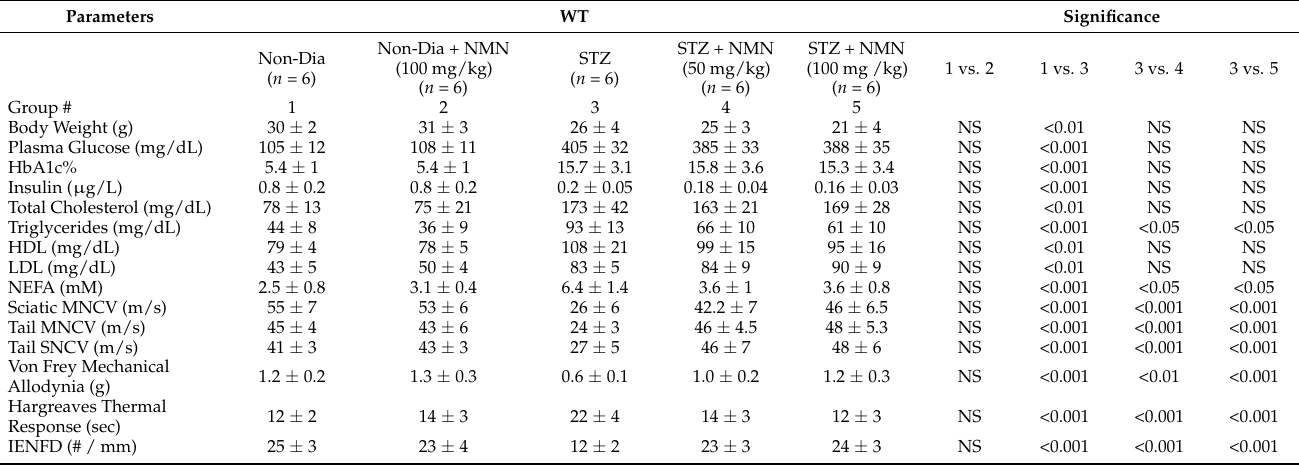
Table 2. Metabolic End Points After 2 Months of Treatment in Non-Diabetic (Non-Dia), Non- Dia + NMN (100 mg/kg intraperitoneal injection on alternate days), Diabetic (STZ), STZ + NMN (50 mg/kg intraperitoneal injection on alternate days) and STZ + NMN (100 mg/kg intraperitoneal injection on alternate days) in C57BL6 Mice. NS = Not